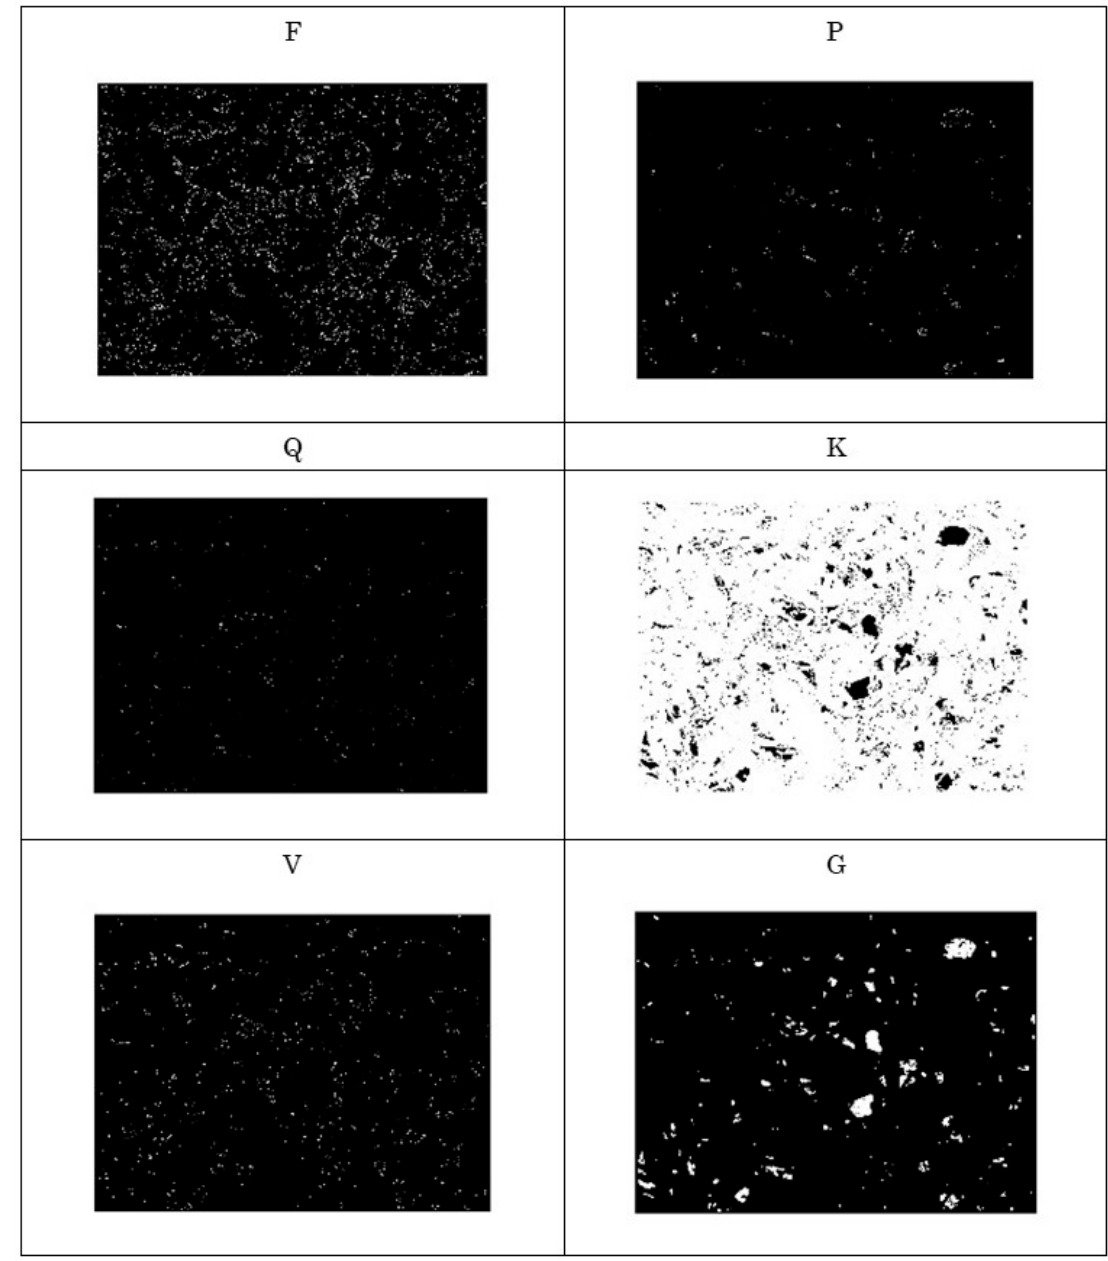
Figure 8. Existence of amino acids denoted as F, P, Q, K, V, and G in Prot k,l based on the ACTG